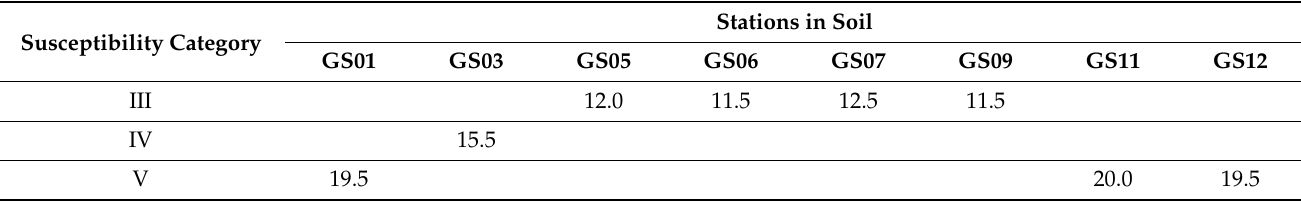
Table 14. Assessment of landslide susceptibility in soils.